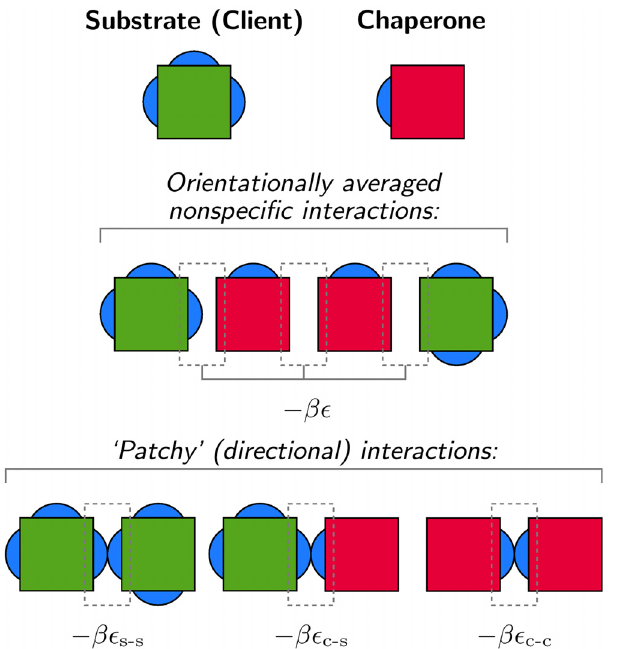
Fig 1. A minimal model of an associating fluid of passive chaperones and aggregation-prone client proteins. Chaperone and client monomers interact via nearest-neighbor interactions on a three-dimensional cubic lattice. Orientationally averaged nonspecific interactions may be either attractive or repulsive. Directional interactions between specific binding sites, indicated by blue patches, depend on the relative orientations of the monomers and are always